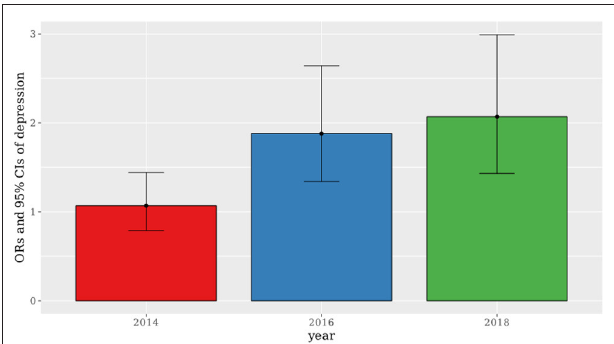
FIGURE 2 | Time series ORs and 95% CIs for depression by secondhand smoke.